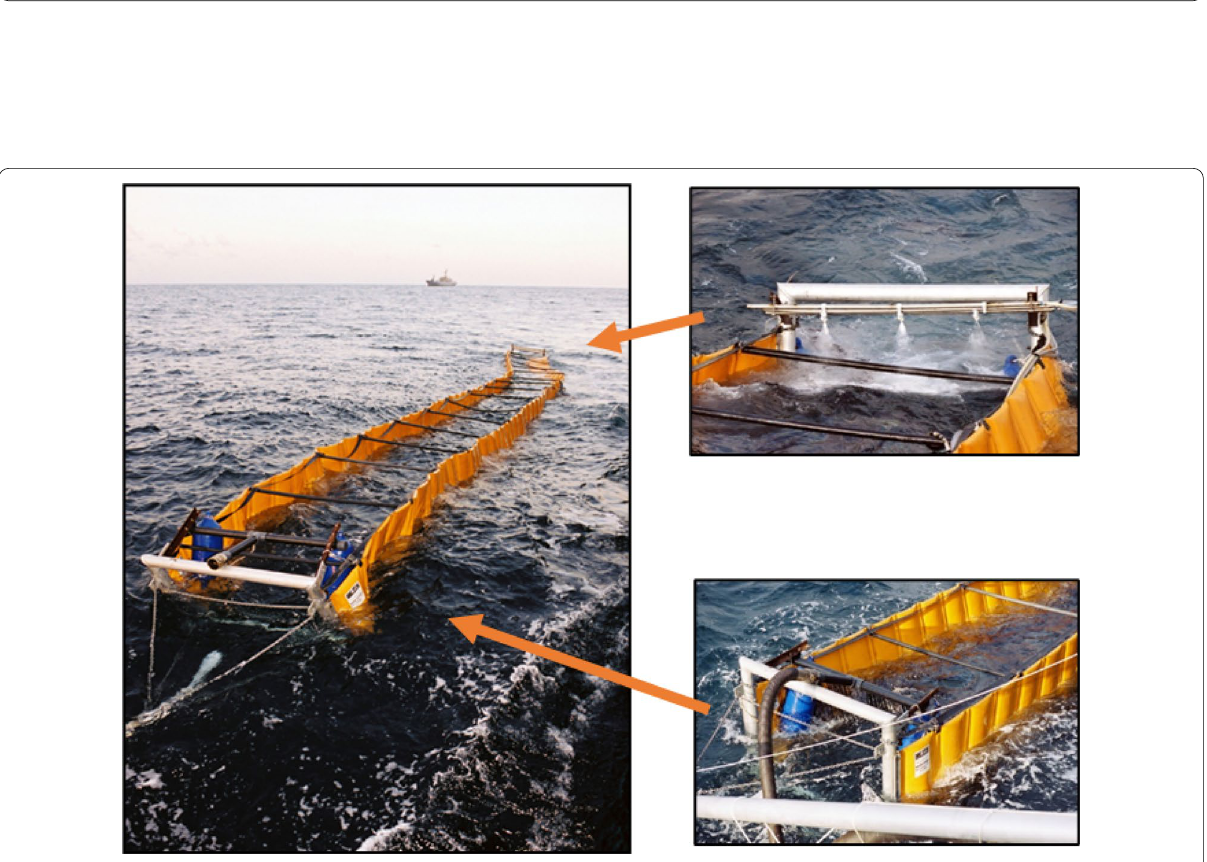
Fig. 7 The “corridor” system. Two parallel floating booms ended by frames, supporting the oil release arrangement at the entrance (bottom right) and the dispersant spray boom at the end (top right). This system has been implemented in 2005, during the French sea trials Depol05, which testing program has been unfortunately stopped prematurely due to a technical incident on the main ship. However, the corridor system proved to be promising: such testing procedure allows to run an important number of comparative tests with limited amount of oil. while working with highly controlled application conditions, especially regarding the DOR (Merlin